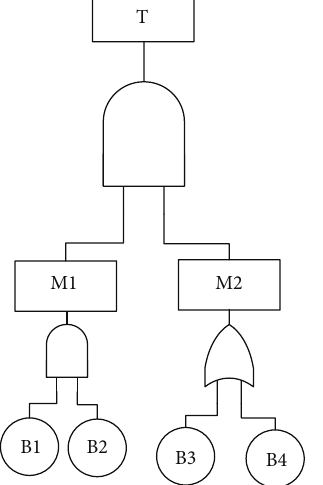
Figure 1: FT model for reliability analysis of a mechanical system.